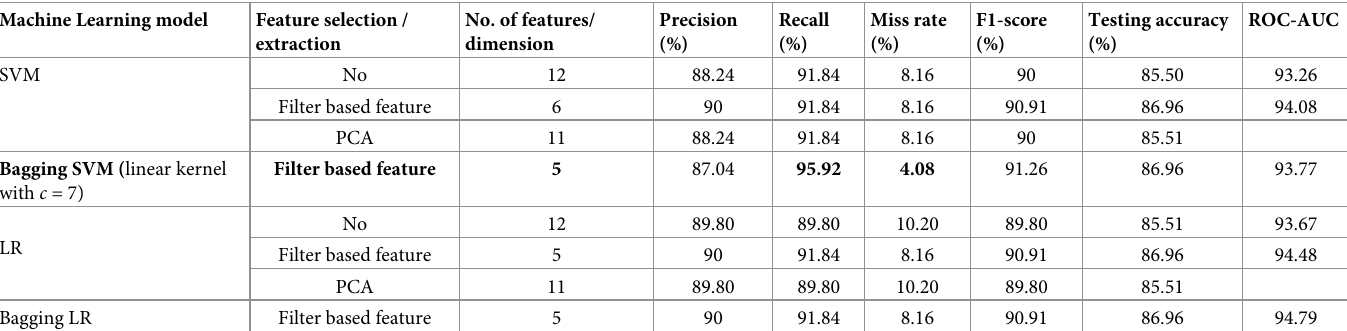
Table 13. Comparison of SVM, LR, bagging SVM and bagging LR. Machine Learning model Feature selection /